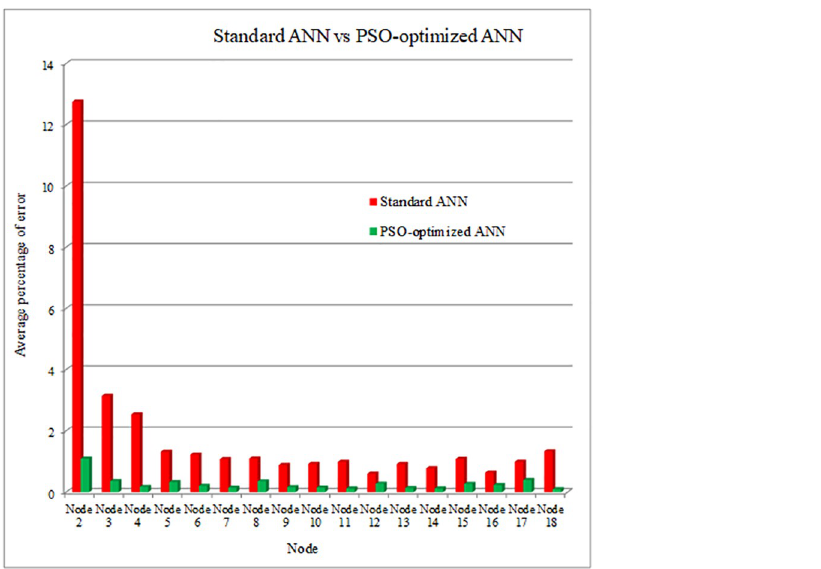
Fig 8. Fault distance estimation result between standard ANN and ANN-PSO.